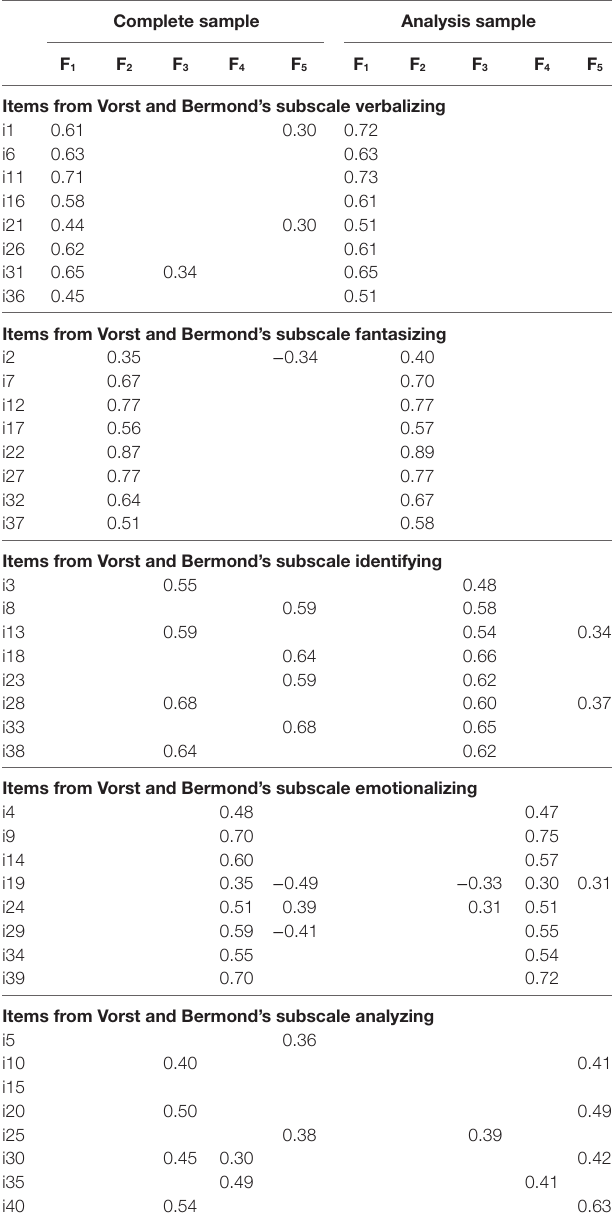
TaBle 2 | Standardized factor loadings of the five-factor model for complete and analysis sample (i.e., without aberrant response patterns). Items are listed in clusters according to the subscales as suggested by Vorst and Bermond’s subscales. Only loadings of 0.3 or higher are